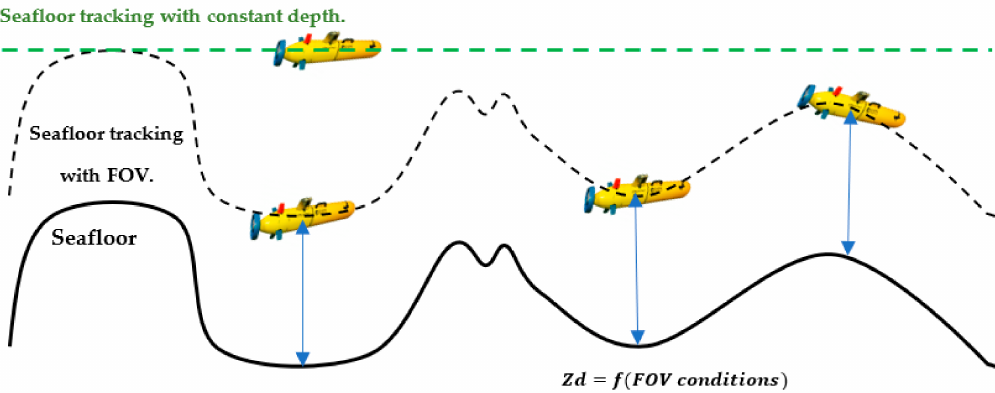
Figure 2. Seafloor tracking with Field of View (FOV) in comparison with traditional seafloor